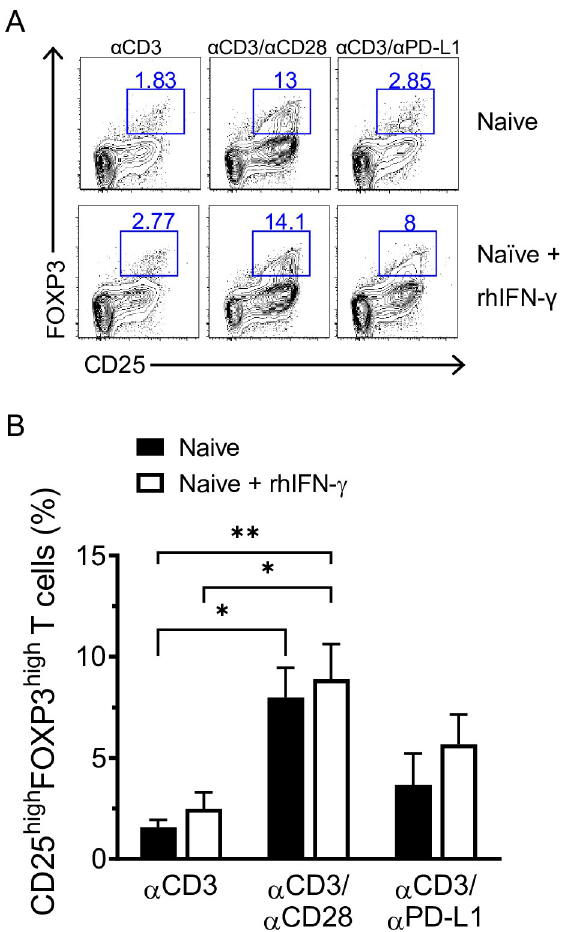
Fig 4. PD-L1 costimulation promotes iTreg conversion of na ï ve T cells in the presence of IFN- γ . ( A ) Representative dot plots showing CD25 and FOXP3 expression after 72 h of culture of na ï ve CD4 + CD25 − T cells isolated from healthy donors in the presence or absence of rhIFN- γ . ( B ) Cumulative results expressed as percentage of CD25 high FOXP3 high T cells. Data are expressed as mean ± SD and are pooled from at least 2 independent experiments ( n = 5). � P < 0.05 and �� P < 0.01 by two-way ANOVA followed by Tukey multiple comparison. Values for each data point can be found in S1 Data. Full gating strategies from representative plots are shown in S1 Gating Strategy. IFN- γ